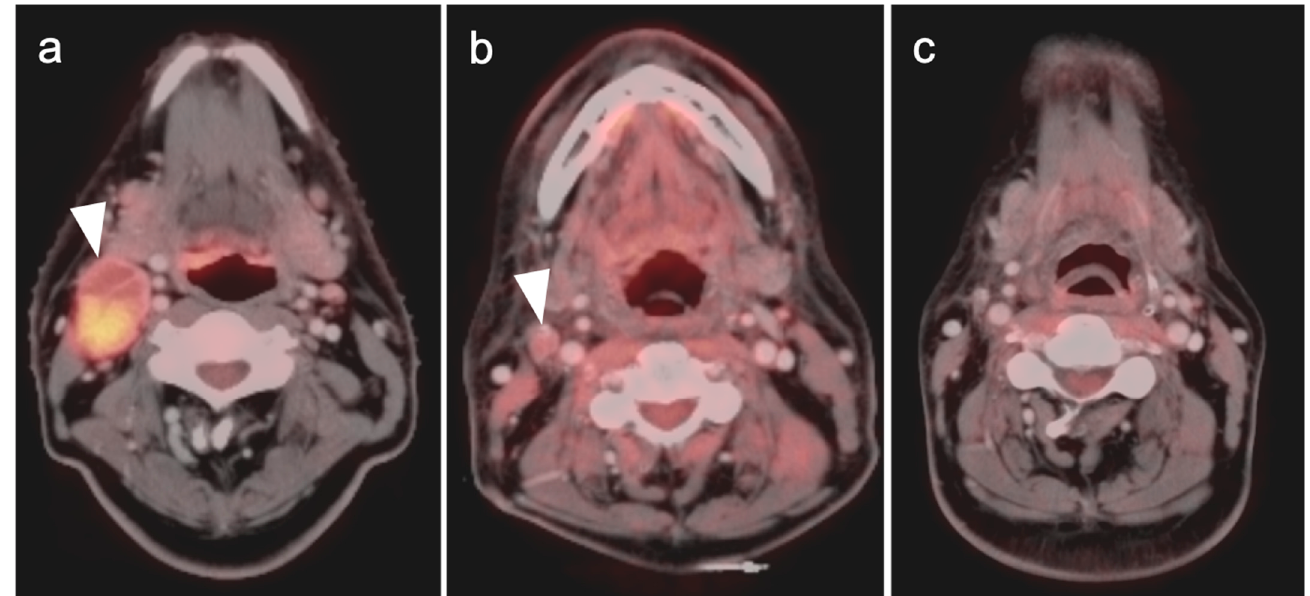
Figure 5. Early post-treatment inflammatory change. ( a ) Axial fused PET CT images prior to therapy demonstrate a hypermetabolic, enlarged pathologic cervical node (white arrowhead): ( b ) On the first post-treatment FDG PET-CT scan, the node has decreased in size and activity following but is still evident (white arrowhead) and has surrounding inflammatory changes and fat stranding; ( c ) Follow-up FDG PET-CT scan 3 months later shows complete resolution of the node and inflammatory stranding. NCCN endorses the use of FDG PET-CT in staging, therapy assessment and